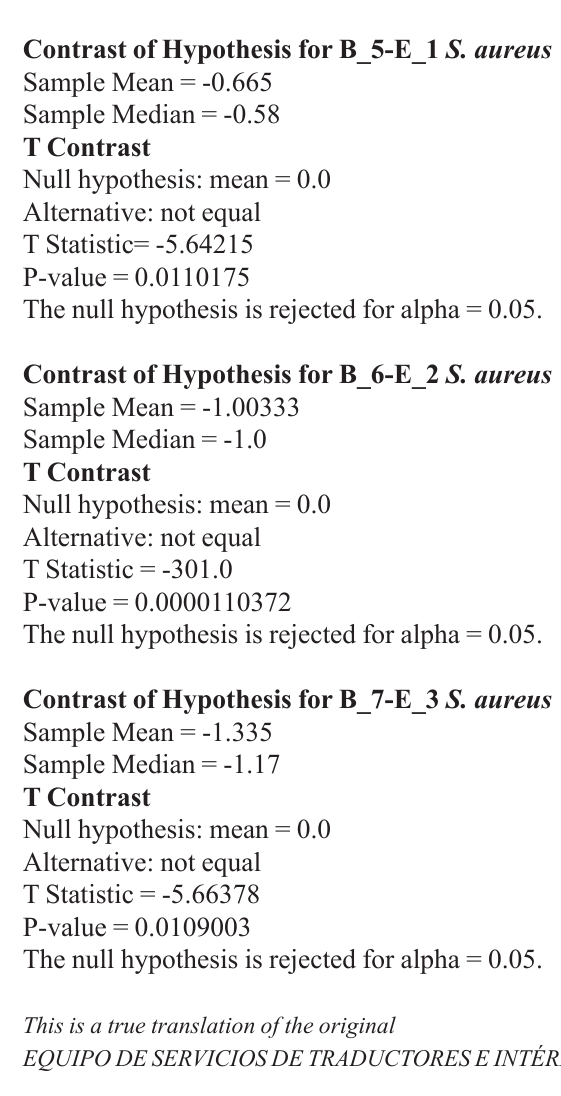
ANNEX 1: Results of the Statistical Analysis in the antimicrobial evaluation in the presence of P.